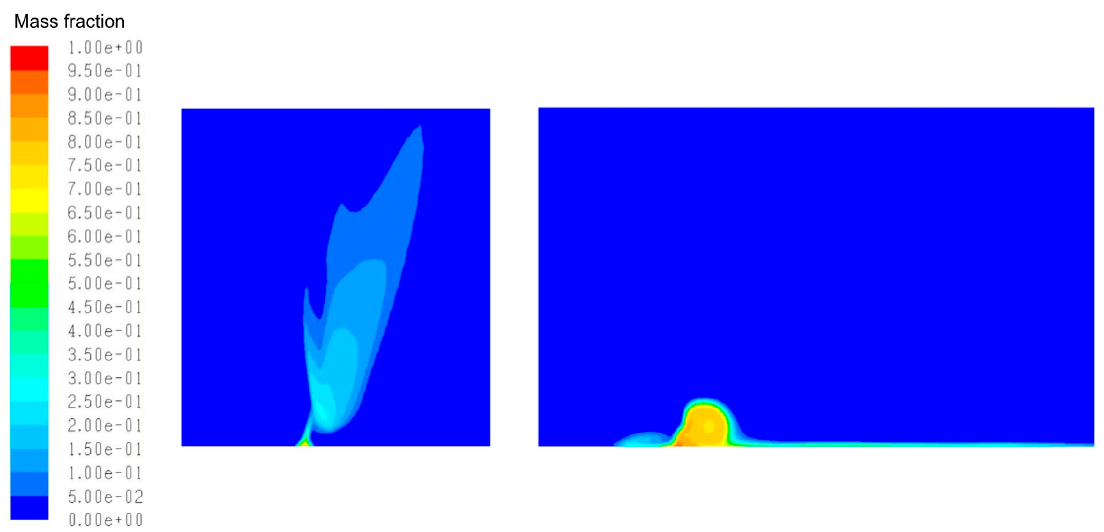
Figure 2. Mass fraction of the pollutants when the contaminant gas is lighter than the air ( left figure ); pollutants when the contaminant gas is heavier than the air ( right figure